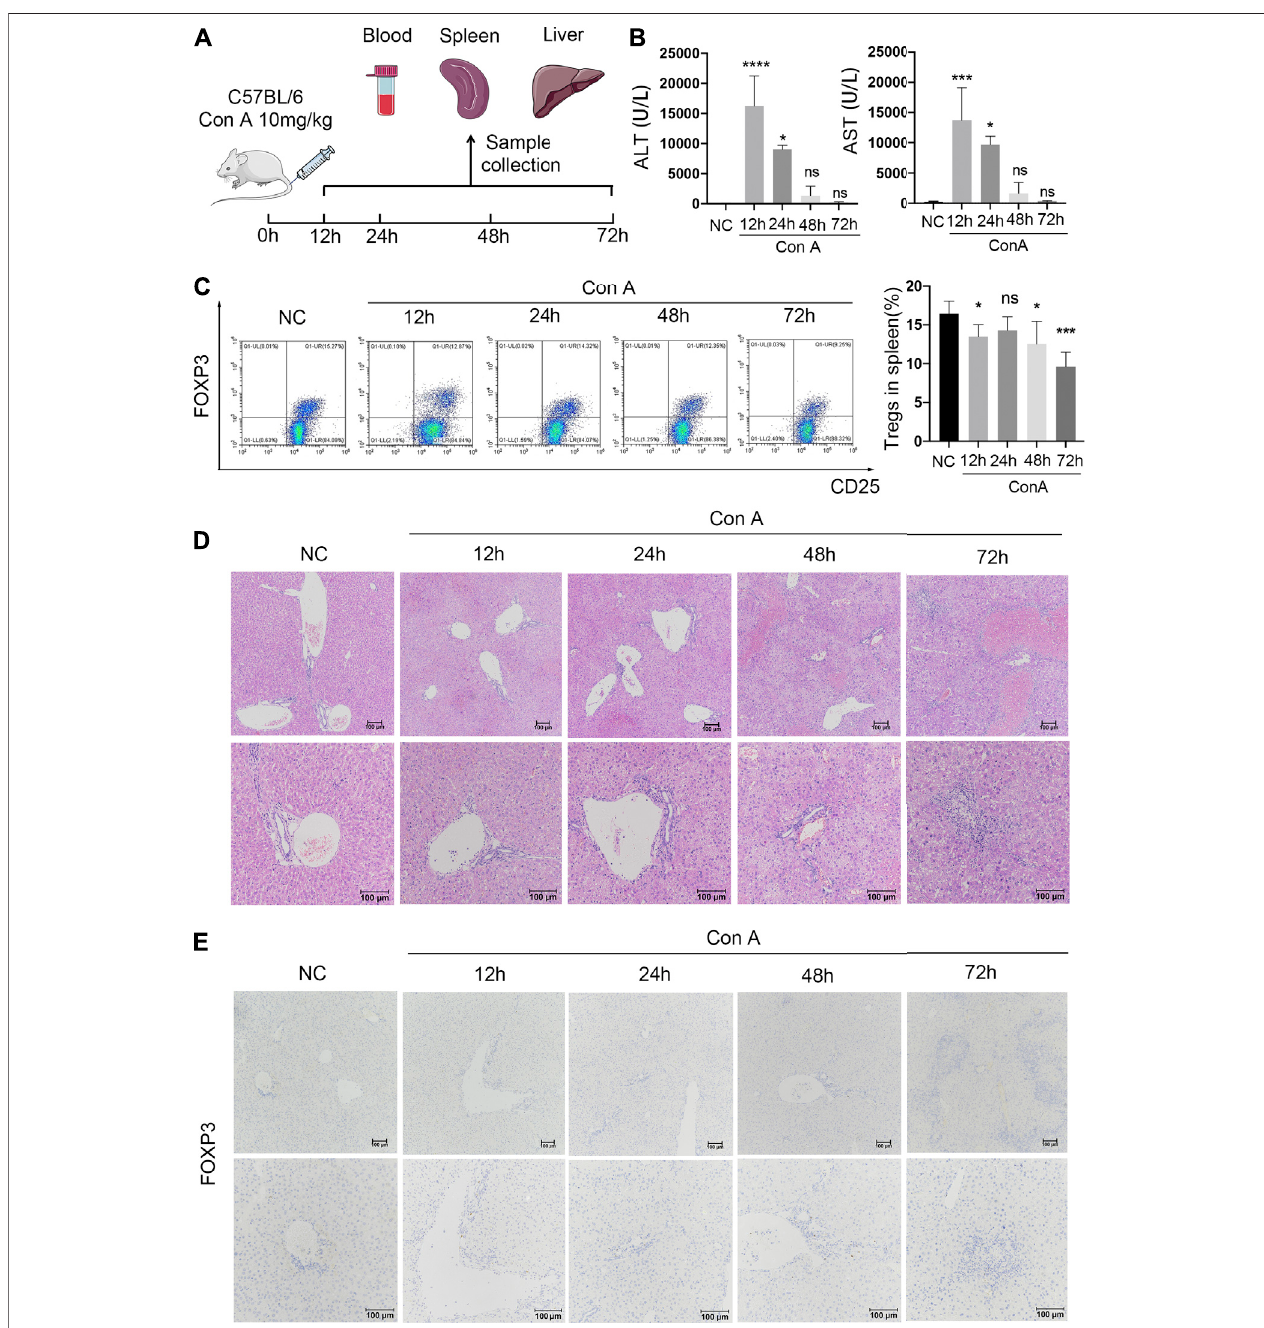
FIGURE 2 | Reduced splenic Tregs and accumulated intrahepatic Tregs in Con A-induced immune hepatitis over time. (A) C57BL/6 mice were injected intravenously with 20 mg/kg Con A. Eyeball blood, spleens, and livers were collected separately at 12, 24, 48, and 72 h after Con A treatment. (B) Serum ALT and AST levels. (C) FCM analysis of splenic Tregs with comparisons between NCs and EAH model mice at different time points. (D) H&E staining of murine liver samples. (E) IHC staining for FOXP3 to evaluate intrahepatic Treg in fi ltration in different groups. Original magni fi cation, 100x and